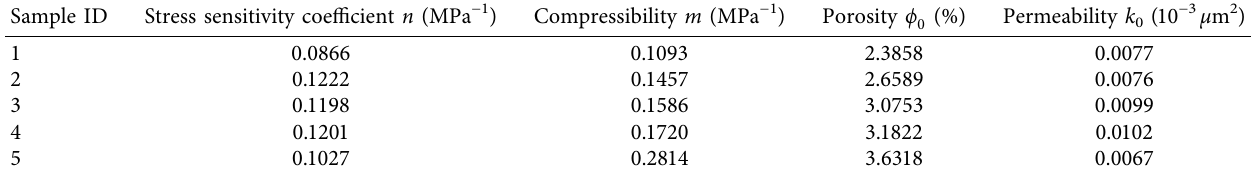
Table 2: Compression coefficients and permeability stress sensitivity coefficients of samples at different effective stresses. Sample